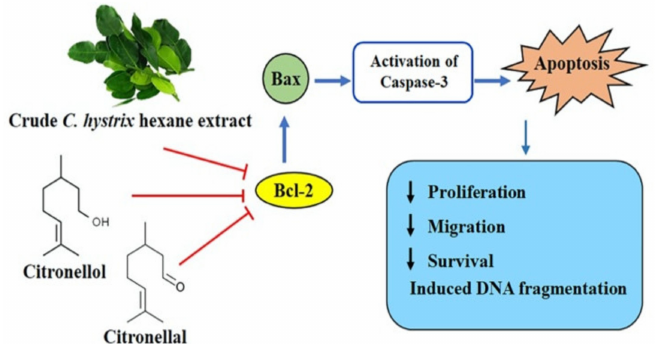
Figure 9. Inhibition of Bcl-2 protein in MDA-MB-231 cells by C. hystrix , citronellal, and citronellol leading to activation of caspase dependent apoptotic pathway.